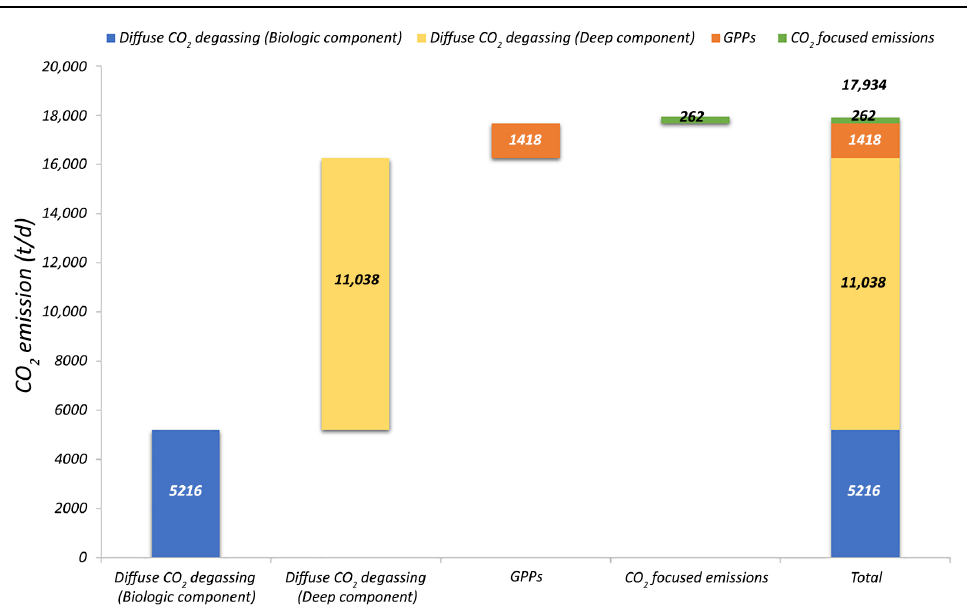
Figure 8. Total CO 2 emissions in AVGA, split in its